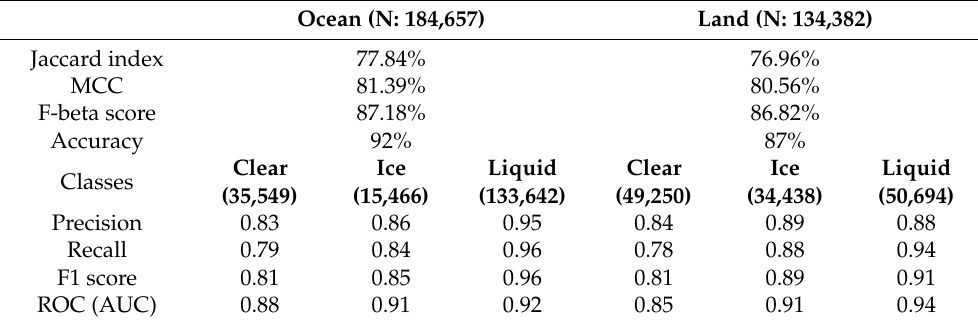
Table 3. Evaluation metrics of the cloud detection neural network model when using a synthetic dataset for MWS sensors trained and validated with ERA5 profiles. The total count of pixels N is in